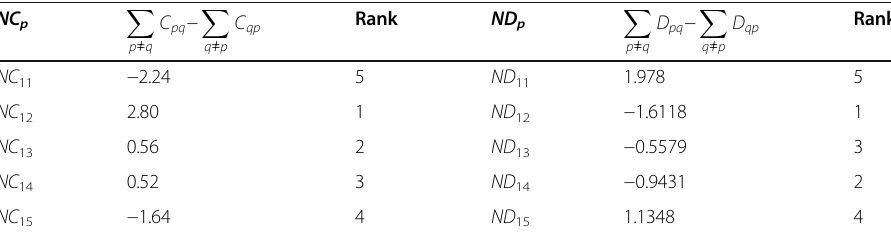
Table 10 Net concordance and discordance indices